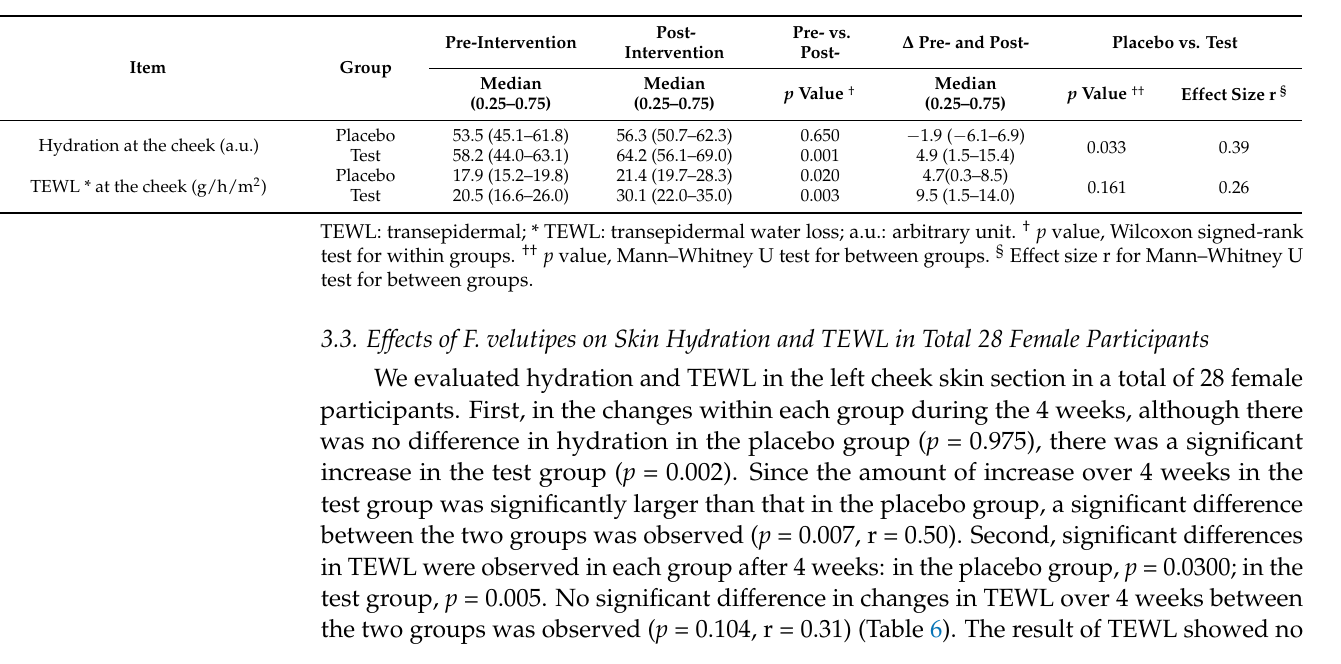
Figure 2. Change in cheek skin parameters in total 30 participants. Figure ( a ): Changes in Skin hydration, ( b ): Changes in TEWL (transepidermal water loss), a.u.: arbitrary unit. Dots beyond the bounds of the whiskers denote outliers. Cross marks and horizontal lines indicate means and medians for each group. Asterisks indicate significant difference in intragroup after the intervention. *: p < 0.05, **: p < 0.01. Table 5. Comparisons of items between the placebo group and the test group in total 30